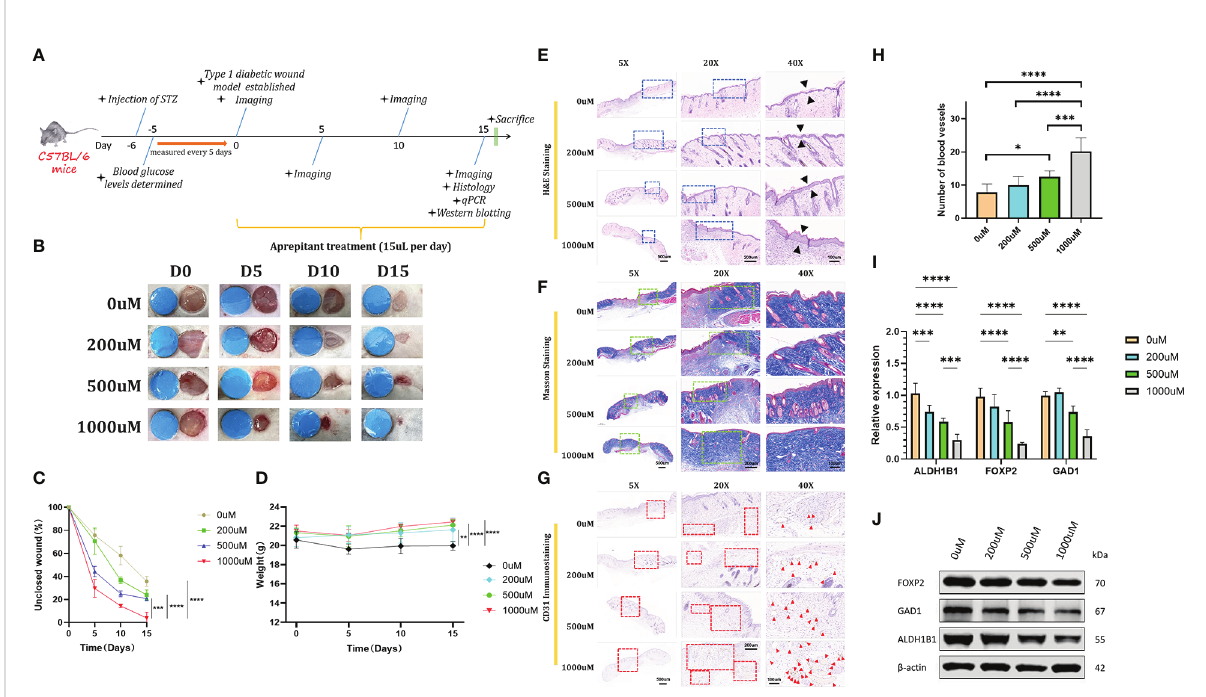
FIGURE 5 (A) Schematic timeline of diabetic wound formation and the following treatments. (B, C) Representative images and quantitative measurement of wounds on days 0, 5, 10, and 15 days. (D) Changes of body weights of mice after different treatments. (E, F) Representative H&E staining images and Masson staining images. (G, H) Representative CD31 immunostaining images after different treatments and the corresponding quantitative data of the CD31-positive blood vessels ’ numbers from respective staining images (40X). (I) qRT-PCR analysis of relative ALDH1B1, FOXP2, and GAD1 levels in different treated groups. (J) Expression of ALDH1B1, FOXP2, and GAD1 levels in different treated groups detected by western blotting analysis. Scale bars: 500 m m for 5X, 200 m m for 20X, and 100 m m for 40X. n=6, ns: no signi fi cant, *p <.05, **p <.01, ***p